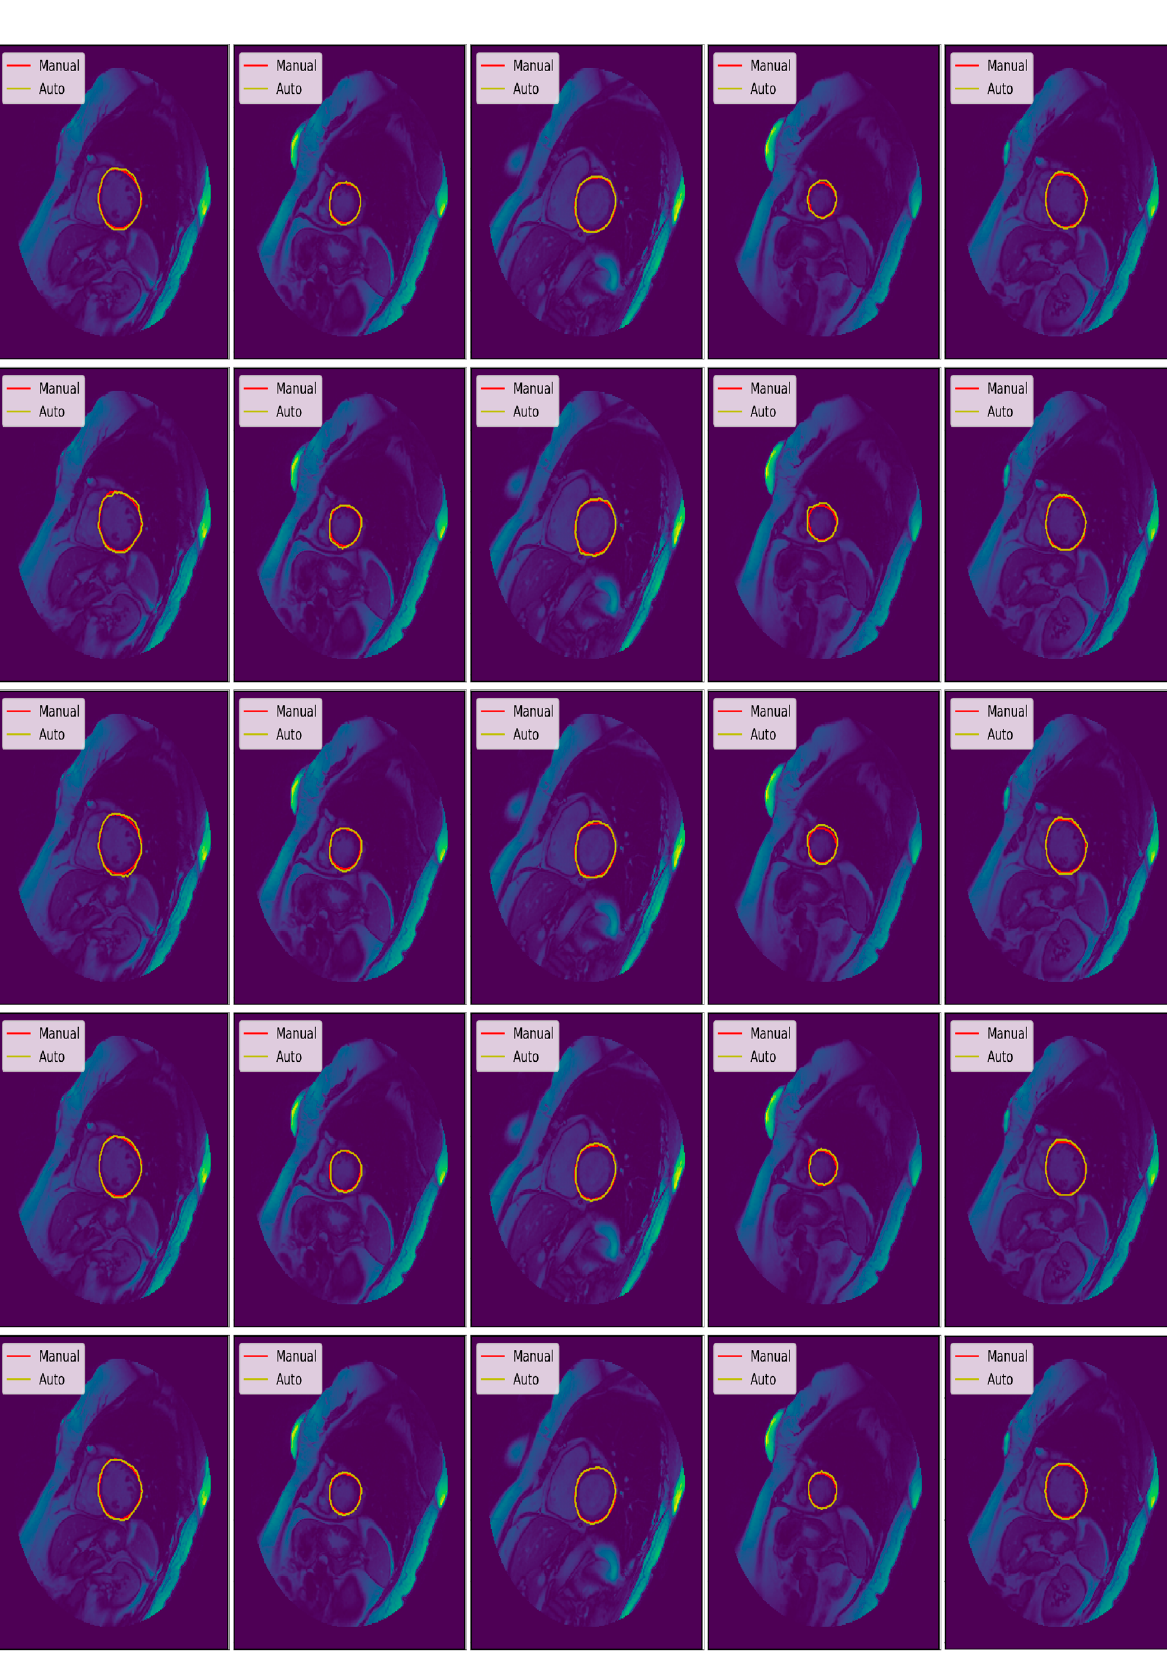
Figure 15. Automatic and manual segmentation results of the epicardium from the training set of a normal subject (SC-N).